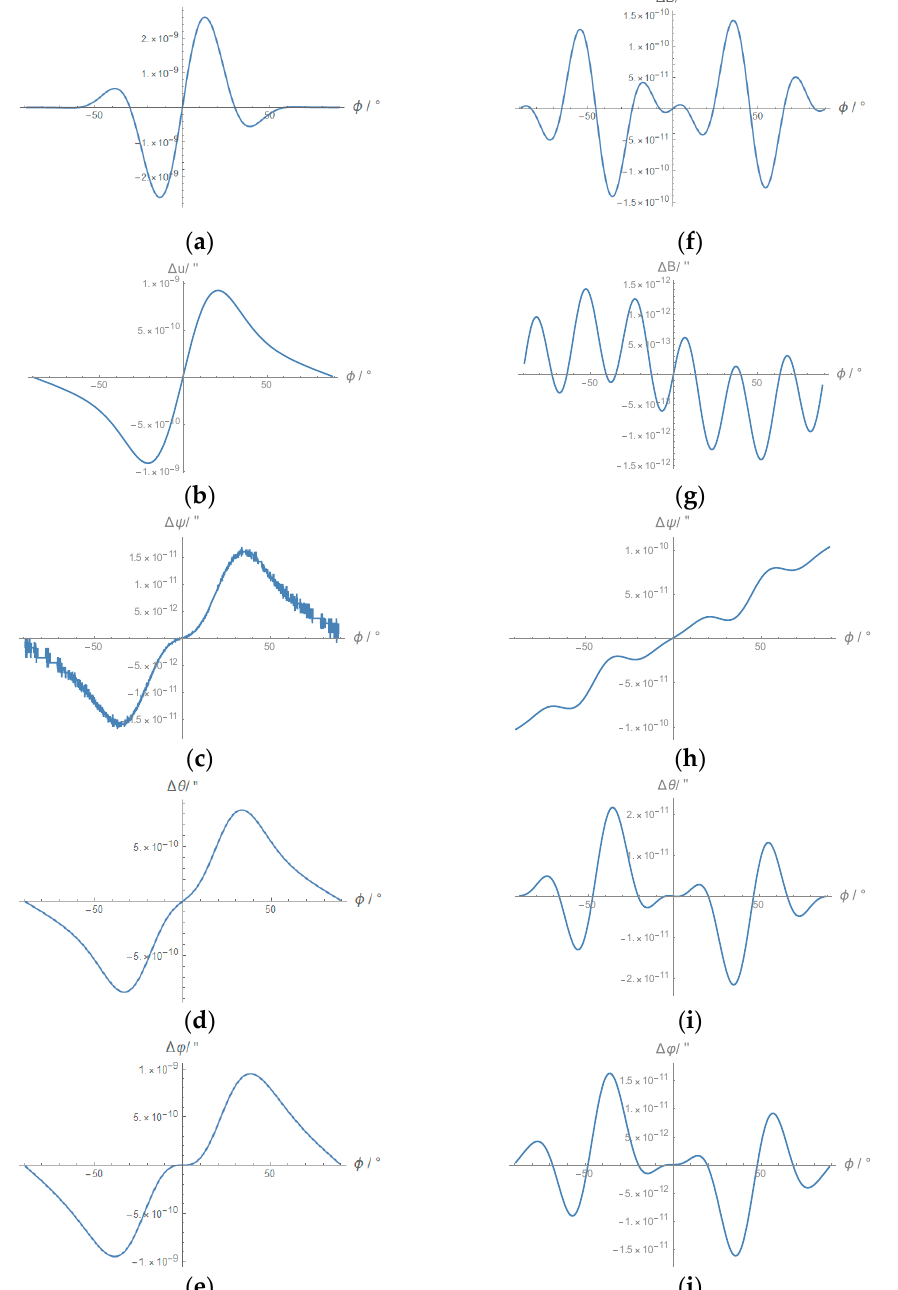
Figure 2. The calculation error of the derived expressions (geocentric latitude as the variable). ( a ) Calculation error ∆ B ( φ ) of geodetic latitude (expanded to e 10 ). ( b ) Calculation error ∆ u ( φ ) of reduced latitude (expanded to e 10 ). ( c ) Calculation error ∆ ψ ( φ ) of rectifying latitude (expanded to e 10 ). ( d ) Calculation error ∆ ϑ ( φ ) of authalic latitude (expanded to e 10 ). ( e ) Calculation error ∆ ϕ ( φ ) of conformal latitude (expanded to e 10 ). ( f ) Calculation error ∆ B ( φ ) of geodetic latitude (expanded to n 5 ). ( g ) Calculation error ∆ u ( φ ) of reduced latitude (expanded to n 5 ). ( h ) Calculation error ∆ ψ ( φ ) of rectifying latitude (expanded to n 5 ). ( i ) Calculation error ∆ ϑ ( φ ) of rectifying latitude (expanded to n 5 ). ( j ) Calculation error ∆ ϕ ( φ ) of conformal latitude (expanded to n 5